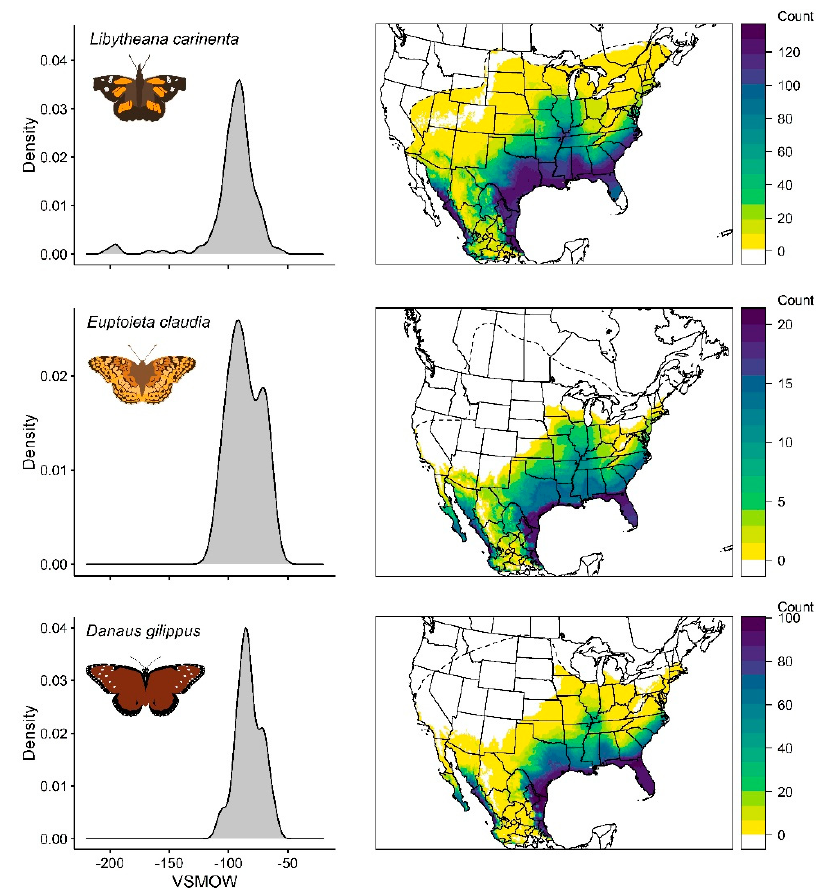
Figure 1. Probabilistic assignment to origin for three (longer-distance) species of butterfly intercepted during fall migration in northeast Mexico, 2019. The figure key refers to the number of individuals assigned per pixel according to a 2:1 odds criterion (see Methods).